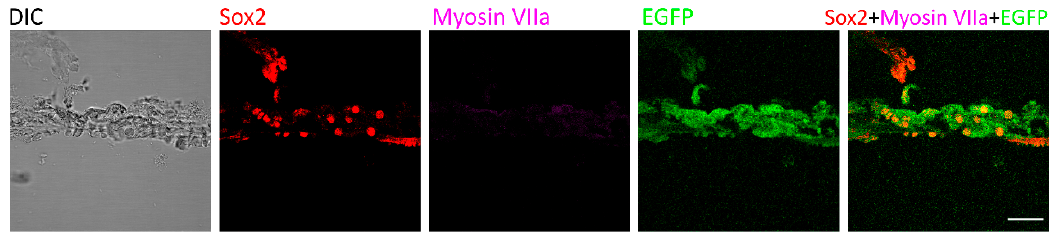
Figure 3. Myosin VIIa expression was not detected in the control mice. Two weeks after saline treatment, the expression of Myosin VIIa was not detected in the control group that was treated with saline following deafening. Sox2 and EGFP were observed in the organ of Corti. Scale bar: 50